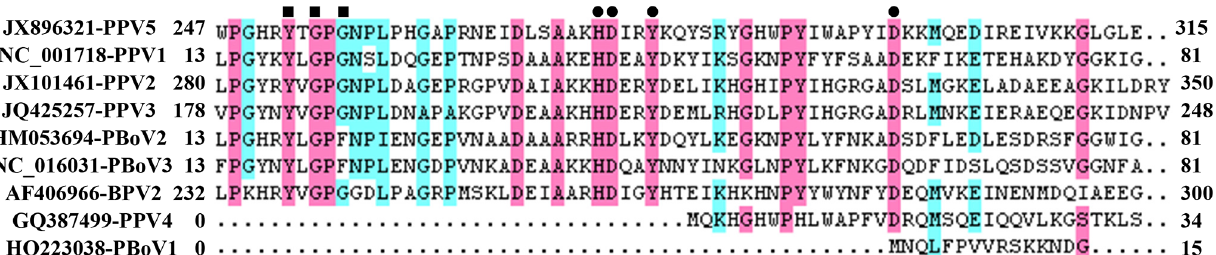
Figure 3. Sequence alignment of the putative phospholipase A 2 motif of PPV5 with those of other PPVs, PBoV, and BPV2. The Ca 2 + binding loop is indicated by filled squares and the catalytic residues by filled circles. The positions of the amino acids and the GenBank numbers of the sequences are indicated.